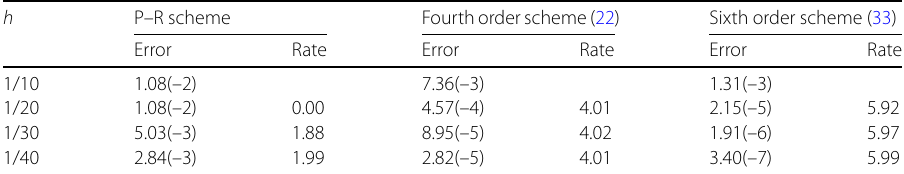
Table 4 L 2 -norm error and convergence rate for Problem 2 with h = τ at T = 1